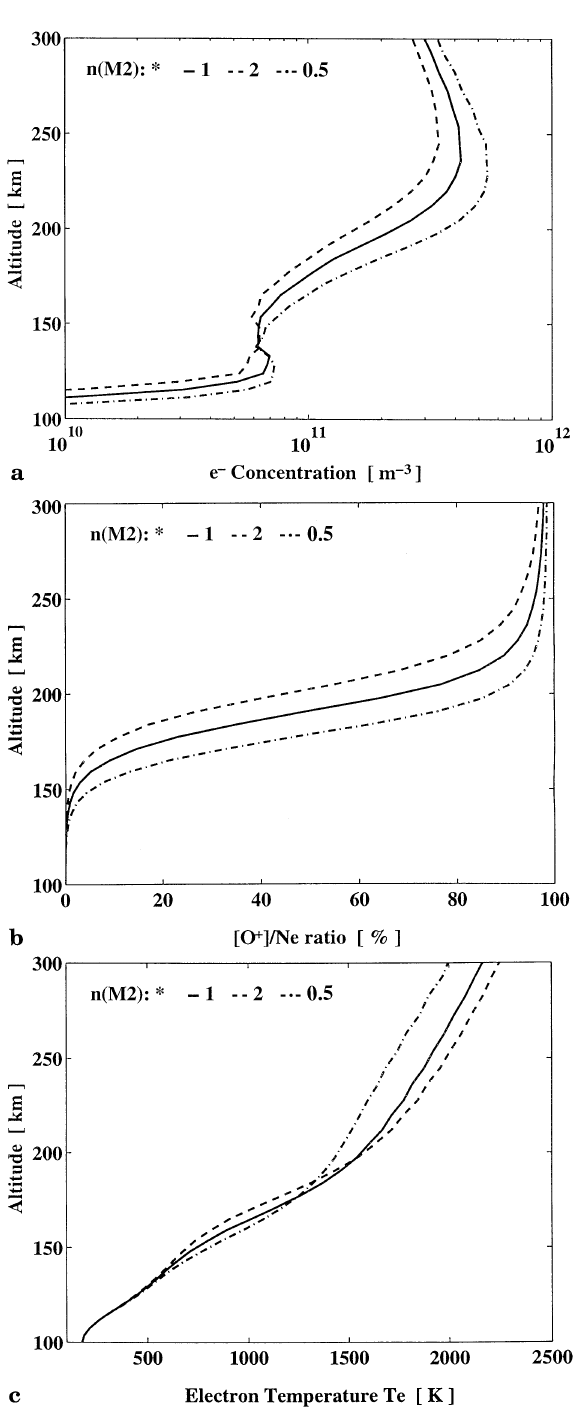
Fig. 6a (cid:177) c. Effect, in the altitude range of interest, of the neutral molecular atmosphere (O (cid:50) and N (cid:50) ) on the profiles of a electron concentration, b O (cid:96) composition parameter and c electron tem- perature. The full line corresponds to the standard adjustment, the dashed line to molecular component concentrations multiplied by 2 and the dot - dashed line to molecular components concentrations divided by